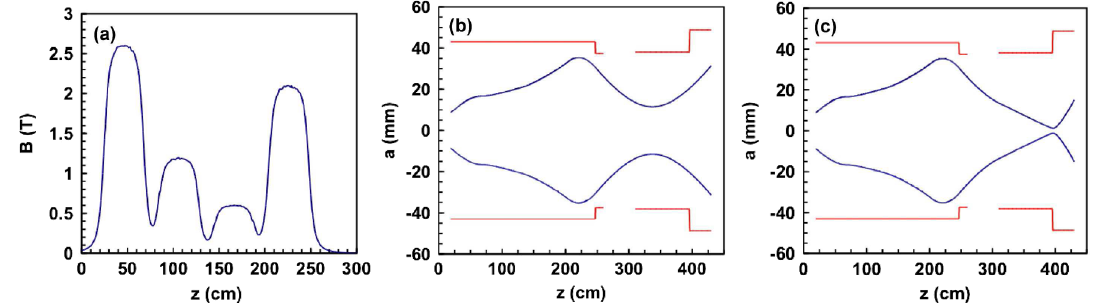
FIG. 2. (a) Axial magnetic field profile based on measurements; (b) calculated beam envelope for an unneutralized beam; and (c) calculated beam envelope for a beam neutralized by the